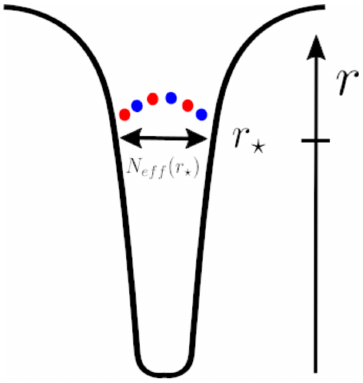
Figure 16 . At small values of the overall volume modulus t . N D 3 the effective membrane of defects pinches off the throat at a radial scale r ∗ s.t. N eff ( r ∗ ) ∼ t